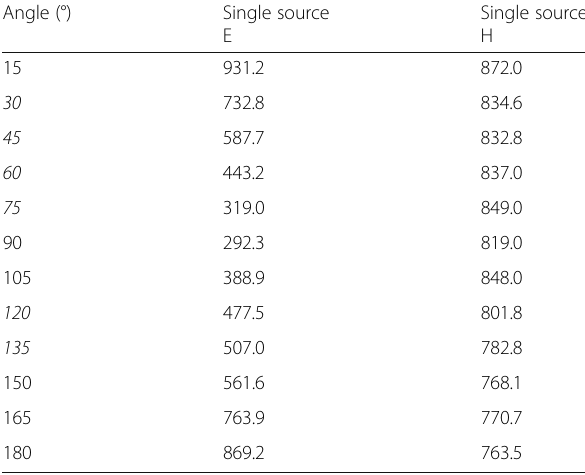
Table 2 Test data for the time-domain directional